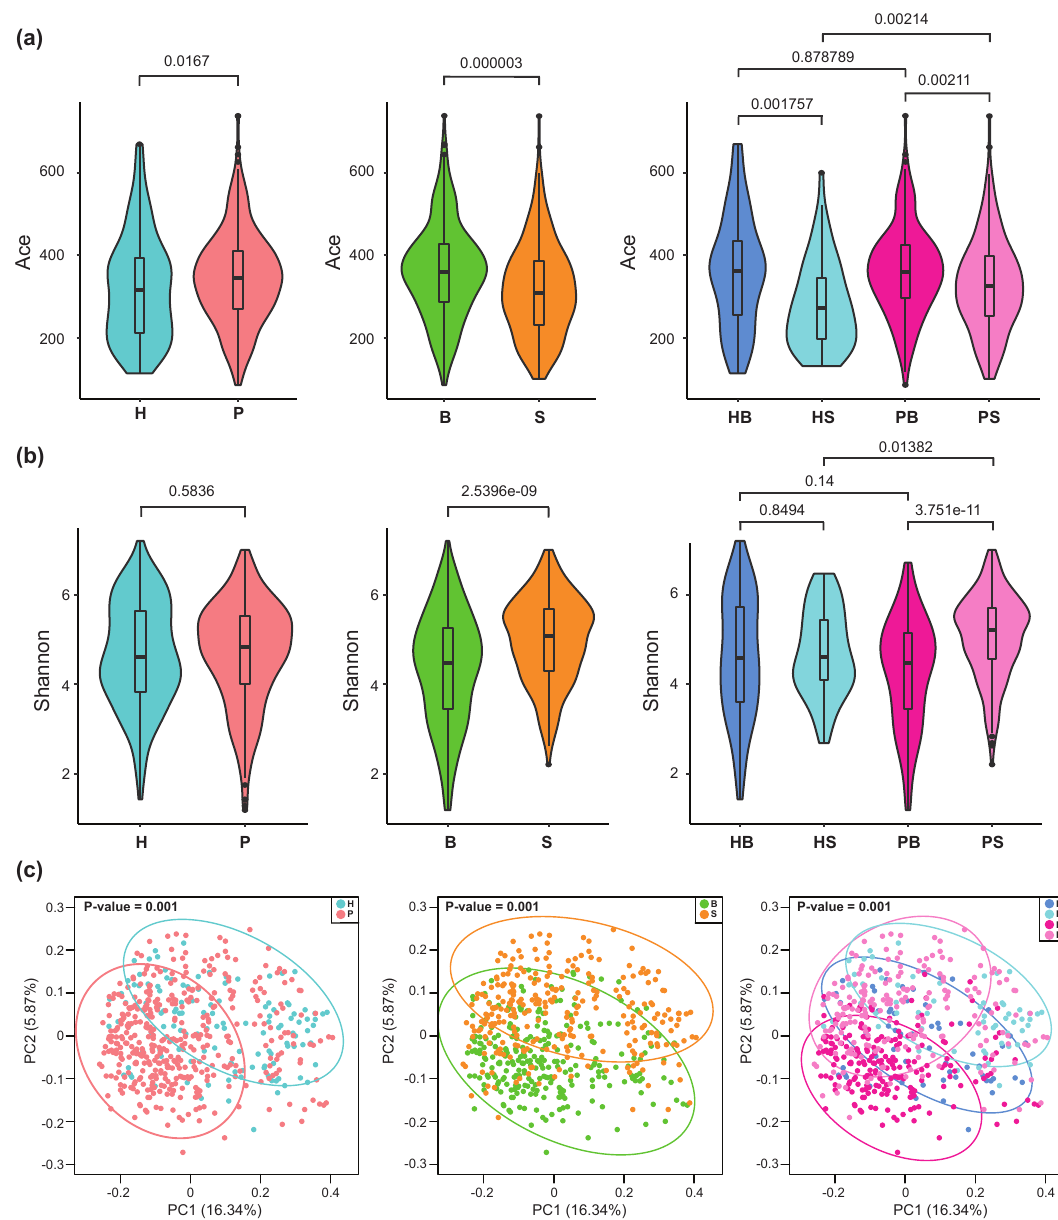
Figure 2. Alpha and beta diversities of bacterial communities grouped by the disease status, sampling sites, and four subject groups. Kruskal–Wallis pairwise test was used to assess the statistical significance between groups for the alpha diversities. In case of beta diversities, permanova test was used to evaluate the statistical significance between groups. ( a ) Alpha diversity—richness (abundance-based coverage estimator; Ace) ( b ) alpha diversity—evenness (Shannon diversity index), ( c ) Principal coordinate analysis plots based on unweighted UniFrac distance. Adjusted P values provided on each plot are for the indicated